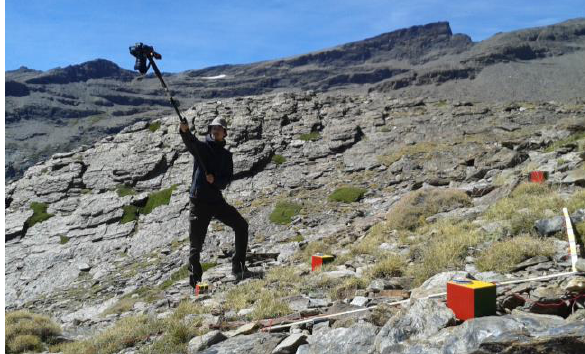
Figure 3. Image collection in the field with a camera attached to an extendable pole. In the foreground a target cube and wooden